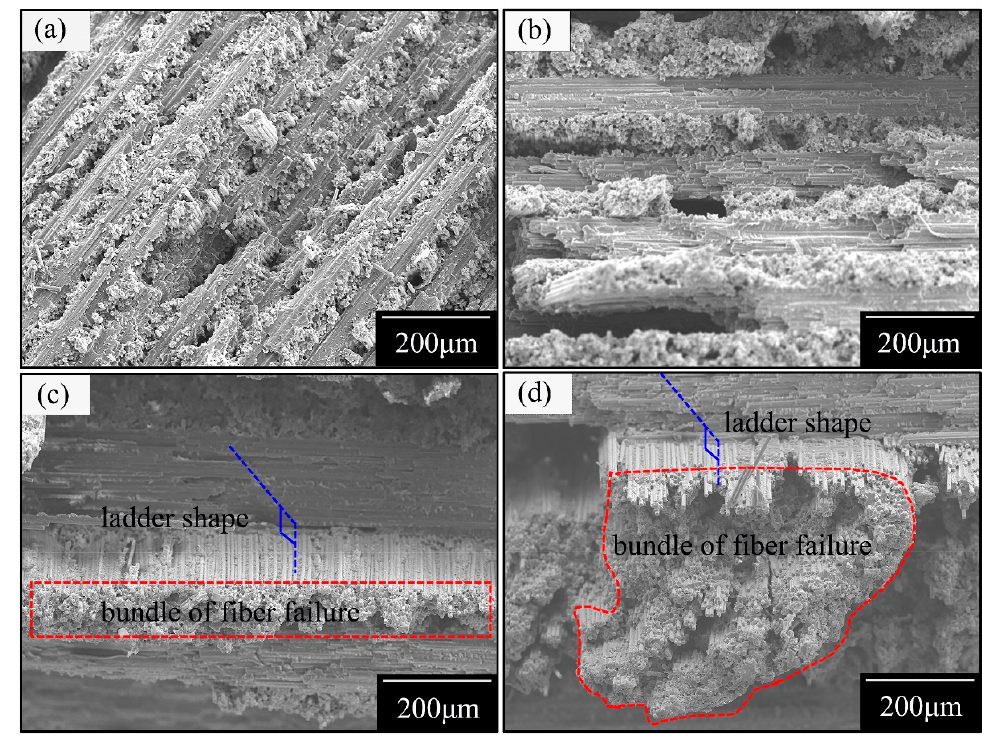
Figure 11. Fracture morphologies under SEM: ( a ) Group A, ( b ) Group B, ( c ) Group C, and ( d ) Group D.